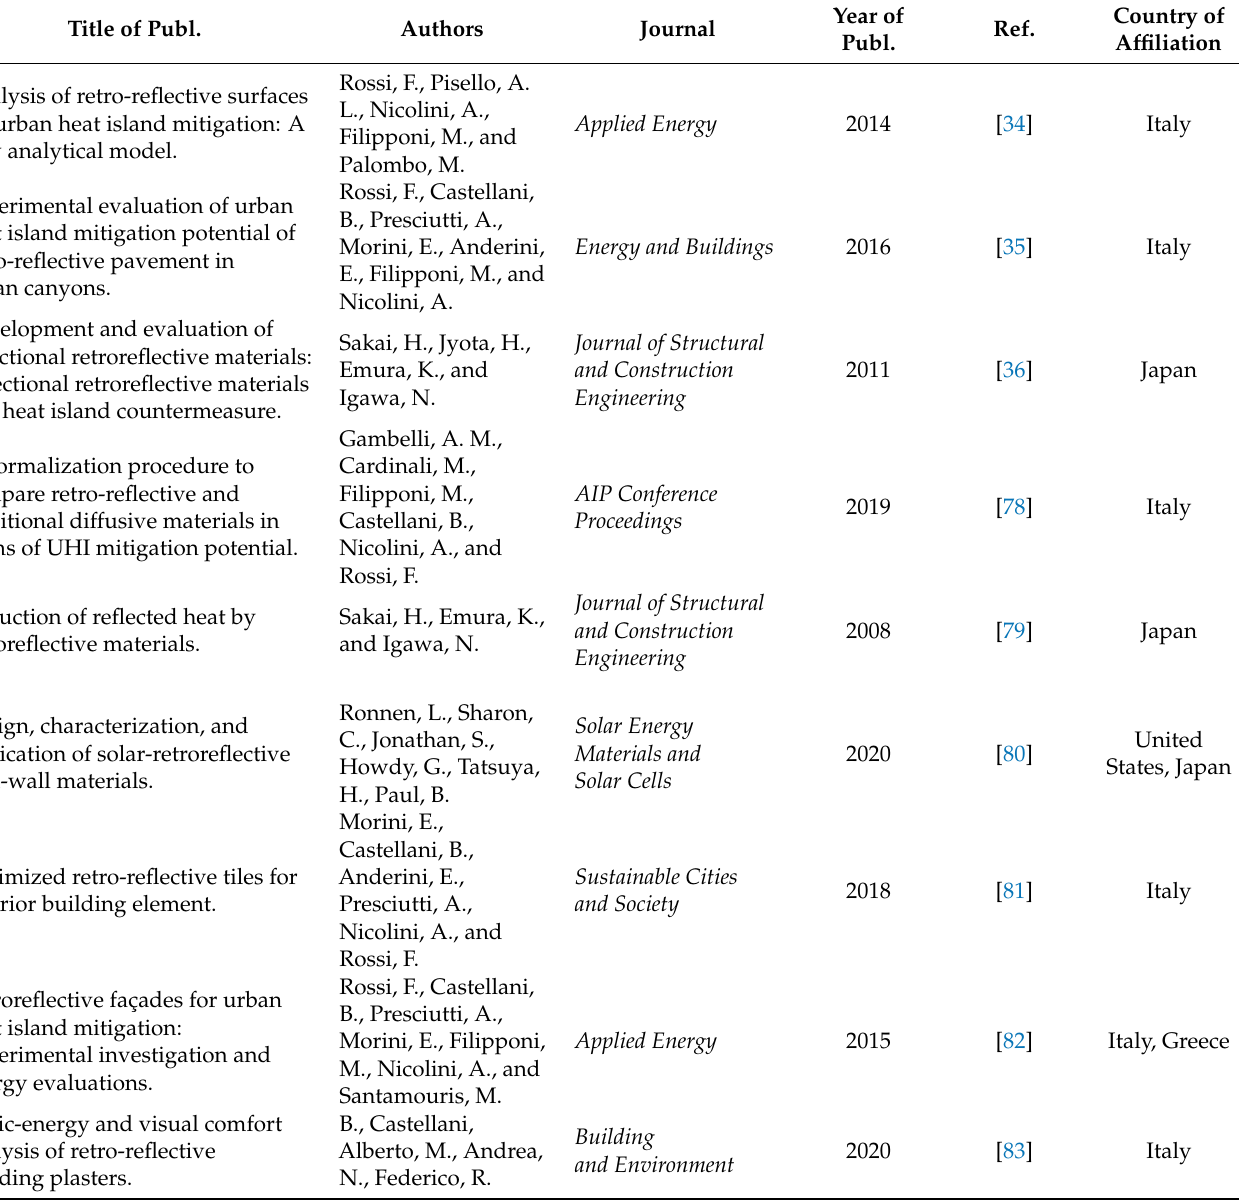
Table 2. Most important publications about RR